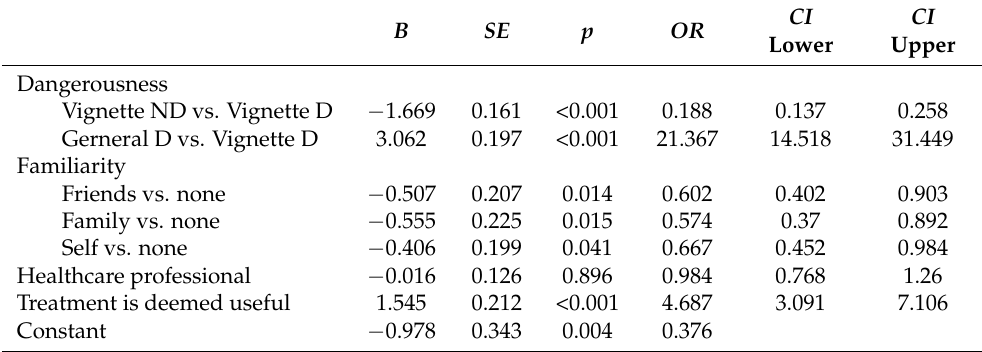
Table 4. Logistic regression model for approval of any type of involuntary